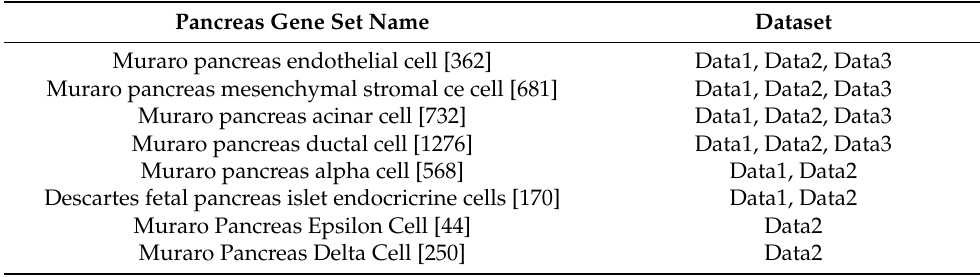
Table 3. List of eight gene sets correlated to the Pancreatic cell types of Data1 resulting from the GSEA analysis.